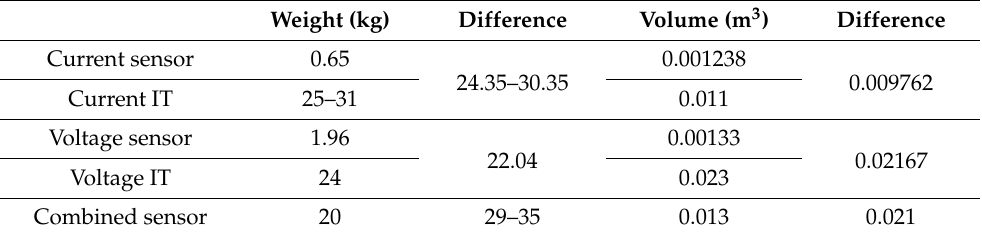
Table 13. IT and sensor weight and volume comparison.